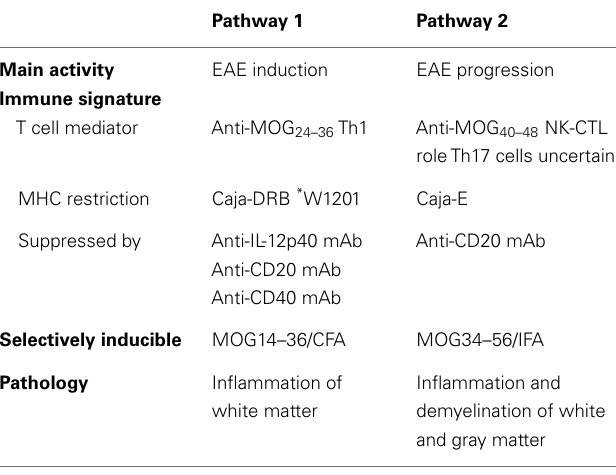
Table 1 | Characteristics of the two autoimmune pathways proposed to elicit clinically evident EAE in marmosets immunized with